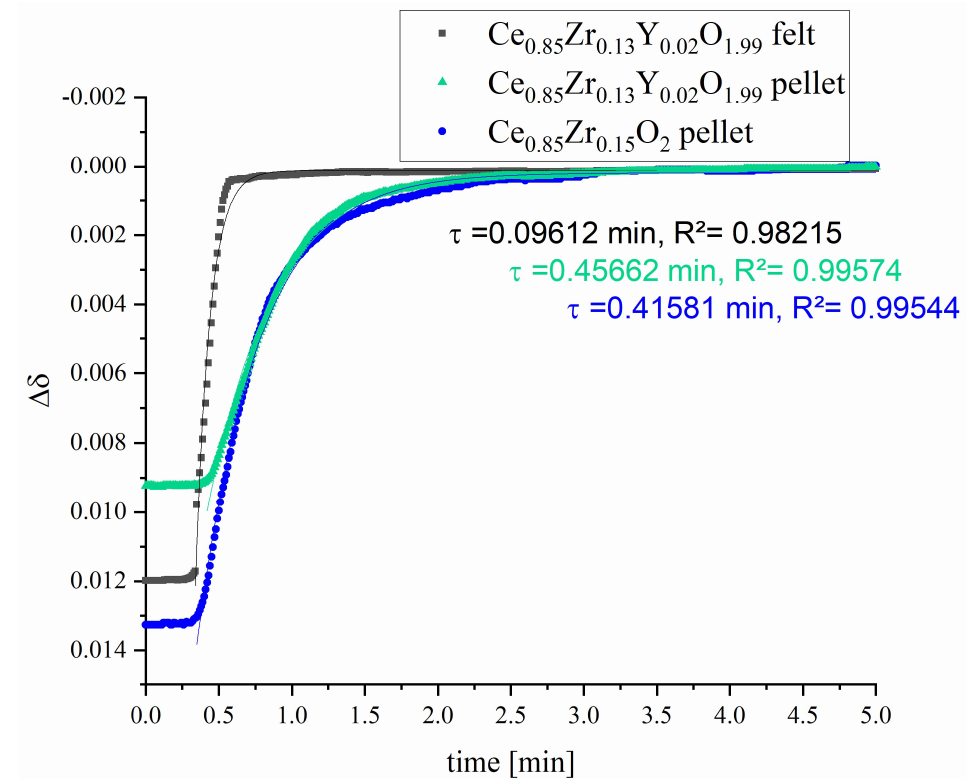
Figure 13. Isothermal time dependence of the mass change during re-oxidation at 1173 K of Ce 0.85 Zr 0.13 Y 0.02 O 1.99 felt and pellet in comparison to Ce 0.85 Zr 0.15 O 2 pellet [51] after reduction at 1373 K. δ 0 is the ∆ δ at time t 0 when the temperature starts to become constant and the gas is changed from argon to air. Time constants, τ , to reach equilibrium are evaluated by fit Equation (4) where the R 2 values quantify the fit